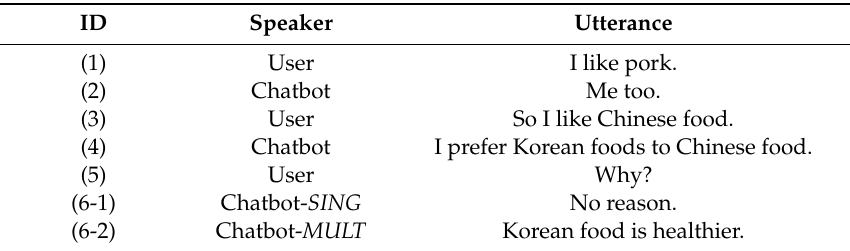
Table 1. Examples of